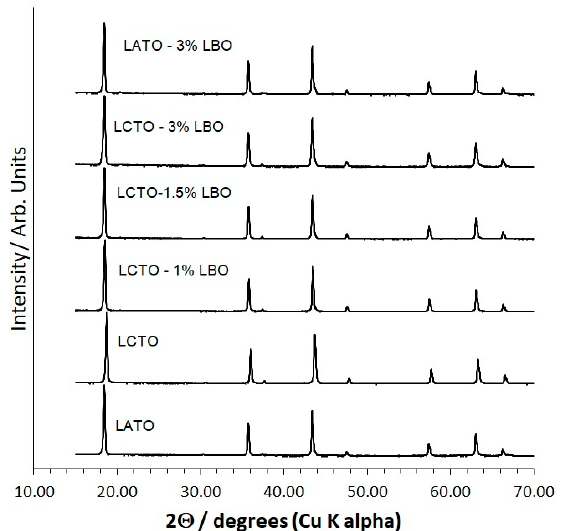
Figure 2. XRD of hot-pressed pellets of Li 1.25 Cr 0.25 Ti 1.5 O 4 (LCTO) and Li 1.25 Al 0.25 Ti 1.5 O 4 (LATO) with variable amounts of Li 3 BO 3 (LBO). Pellets were ground to a powder prior to XRD data collection. LBO is not detected in the XRD pattern owing to the light elements present and the low concentration. Generally, phases at or below a few weight% are not detected and